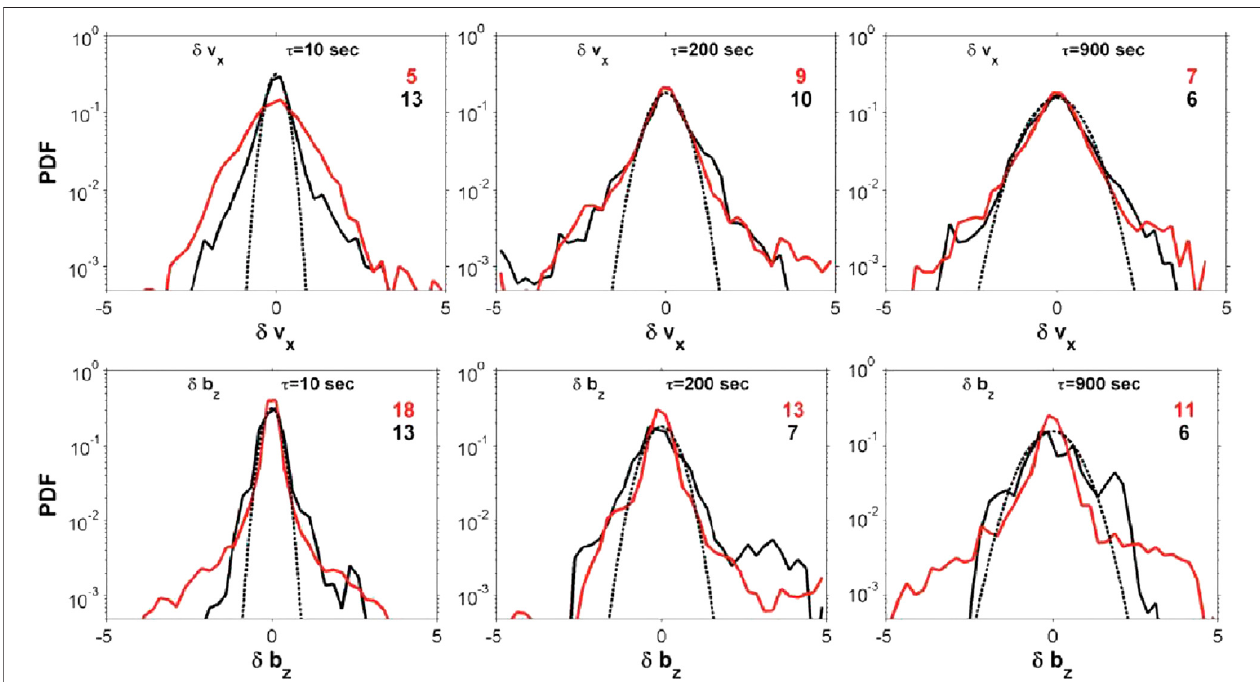
FIGURE 10 | Probability Distribution Functions calculated from the simulation (black) and from THEMIS P5 observations (red). The top panels are based on the Vx component of velocity and bottom panels are based on Bz. The dashed line is a Gaussian fi t. The numbers at the top give the kurtosis. (From El-Alaoui et al.,